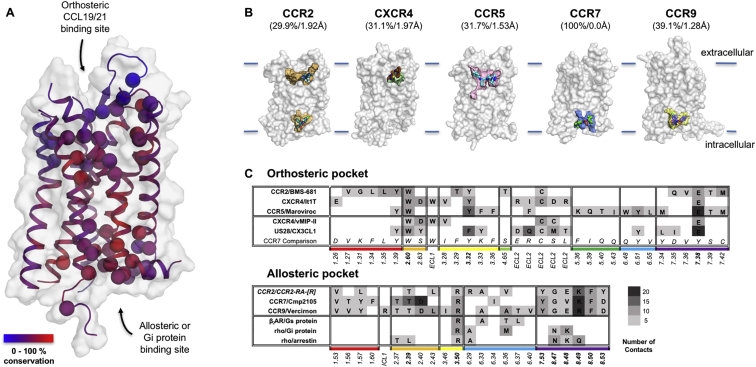
Conservation Patterns of the CCR7 Orthosteric and Allosteric Ligand Binding Site Compared to Other Chemokine Receptors, Related to Figure 3(A) Small molecules can inhibit chemokine receptors through either the extracellular orthosteric binding pocket, the chemokine (e.g., CCL19/21) activation site, or the intracellular allosteric pocket, which interacts with signaling partners like G proteins. The Cα backbone atoms of residues in contact with small molecule ligands in human chemokine receptors are plotted on the structure of CCR7 (spheres, conservation from blue to red). (B) Illustration of the size, shape, and position of the small molecule binding pockets in respect to the cellular membrane (blue bars). Numbers in brackets indicate sequence identity to CCR7 and root means square deviation of Cα atoms in transmembrane helices. (C) Interatomic contacts (defined as pair of atoms with < 4 Å distance) between chemokine receptors with small molecule ligands (PDB: 5T1A, 3ODU, 4MBS, and 5LWE), chemokines (PDB: 4RWS and 4XT1) and a selection of GPCR-effector complexes (PDB: 3SN6, 6CMO, and 5DGY). Overall a higher overlap between contact sites is observed in the tight intracellular allosteric binding pocket overlapping with the GPCR-effector binding site. The gray-scale indicates the number of contacts to the respective ligand. The orthosteric binding pocket has a higher level of sequence variation compared to the allosteric site. It is wide open and highly polar to allow binding of chemokines which are, with approximate sizes of 8 to 12 kDa, much larger compared to a typical class A GPCR ligand. Synthetic small molecule ligands of chemokine receptors, therefore, target a smaller subpocket as observed for IT1t in CXCR4 (Wu et al., 2010) and BMS-681 in CCR2 (Zheng et al., 2016) or several subpockets like the HIV drug Maraviroc in CCR5 (Tan et al., 2013). In the CCR7 structure much of the homologous pocket surface is occupied by a desirable mix of hydrophobic and polar residues as interaction points for small molecules with an average conservation 58% between human chemokine receptors. Of particular interest for the design of orthosteric CCR7 ligands are Trp1142.60 and Tyr1363.32 where the corresponding residue is highly conserved and is directly interacting with a ligand in all known structures. Tyr3127.38, on the other hand, is a ligand-interacting glutamate in CCR2, CXCR4 and CCR5 but hydrogen-bonding to Tyr1363.32 in case of CCR7. Finding and exploring such variations in the orthosteric binding pocket will help to optimize selective ligands to pharmaceutically target CCR7 once initial hits have been identified.